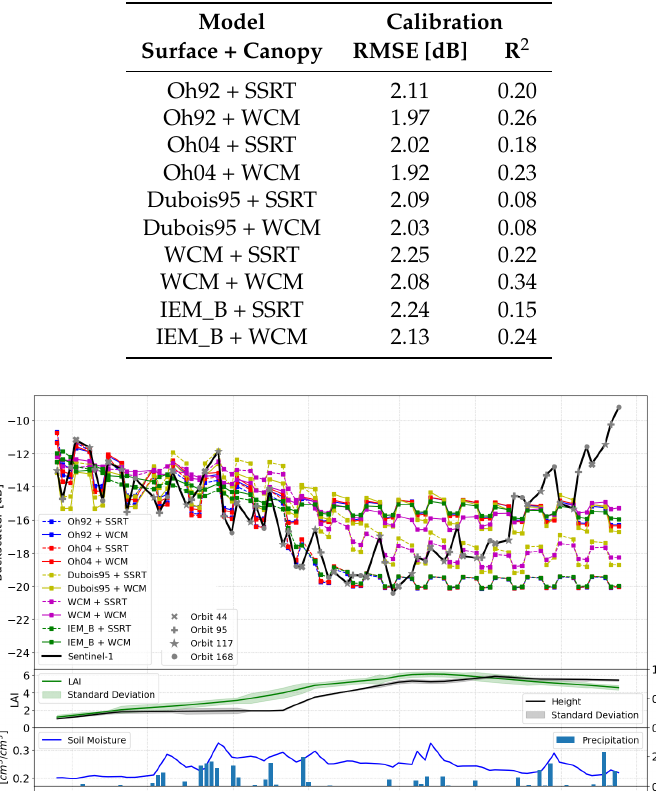
Table 6. Calibration results of different model combinations with static empirical parameters. Mean RMSE, ubRMSE, and R 2 of all analyzed field measurement points.